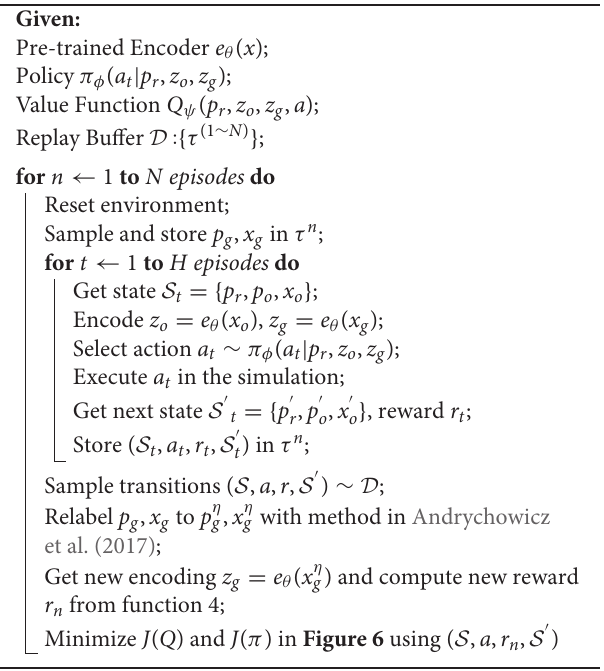
Algorithm 1: RL with Vision-Proprioception Model